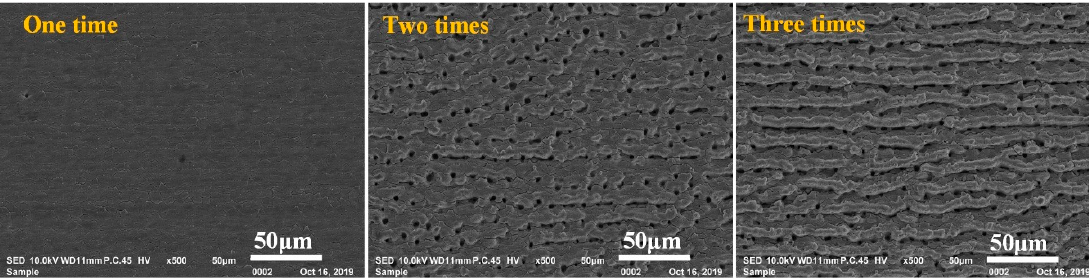
Figure 7. Effect of irradiating times on the morphology of Ti–6Al–4V surface at the laser fluence of 2.9 J/cm 2 .